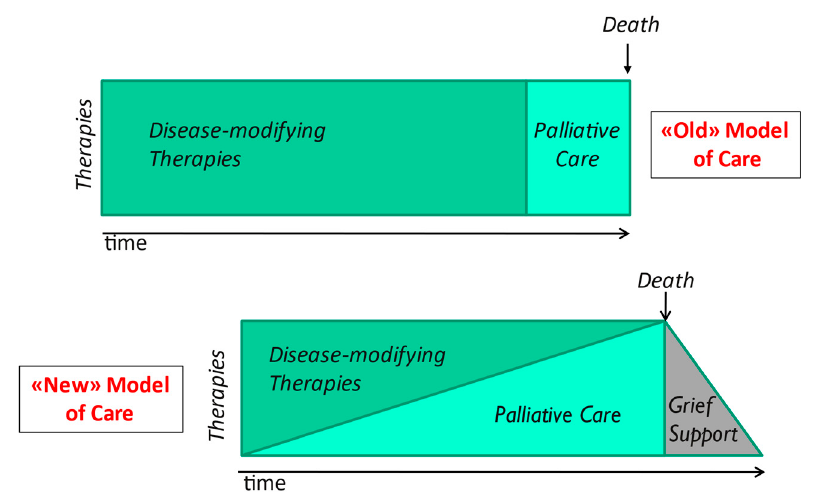
Figure 1. The different models to initiate palliative care .